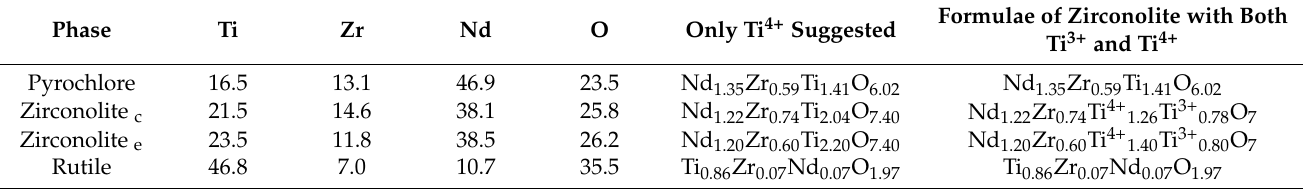
Table 5. Phase compositions averaged over three to five determinations ( c —center, e —edge), wt%, and zirconolite formulae calculated for four cations (without Ti 3+ ) or four cations and 7O 2- (accounting for Ti 3+ ).